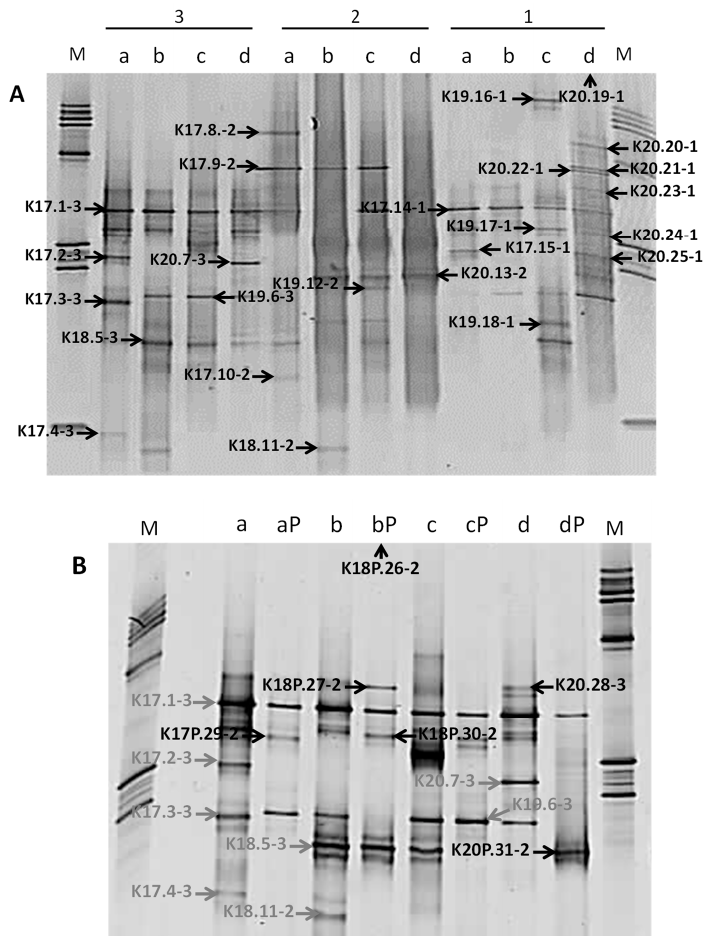
Figure 5. DGGE profiles of bacterial 16S rRNA gene fragments from deep Triassic sandstones. ( A ) Bacterial diversity as assessed by three DNA extraction methods (1 to 3) from rocks stored under atmospheric pressure. ( B ) DGGE profiles of bacterial community from Triassic sandstones stored under high pressure. For samples stored under high pressure, environmental DNA was extracted with the method 2 only. Excised DGGE bands were identified with an arrow. M: ladder, a: K2-20 core (EST31467), b: K2-19 core (EST31602), c: K2-18 core (EST31571), d: K2-17 core (EST31387), P: stored under high pressure (190 bars).